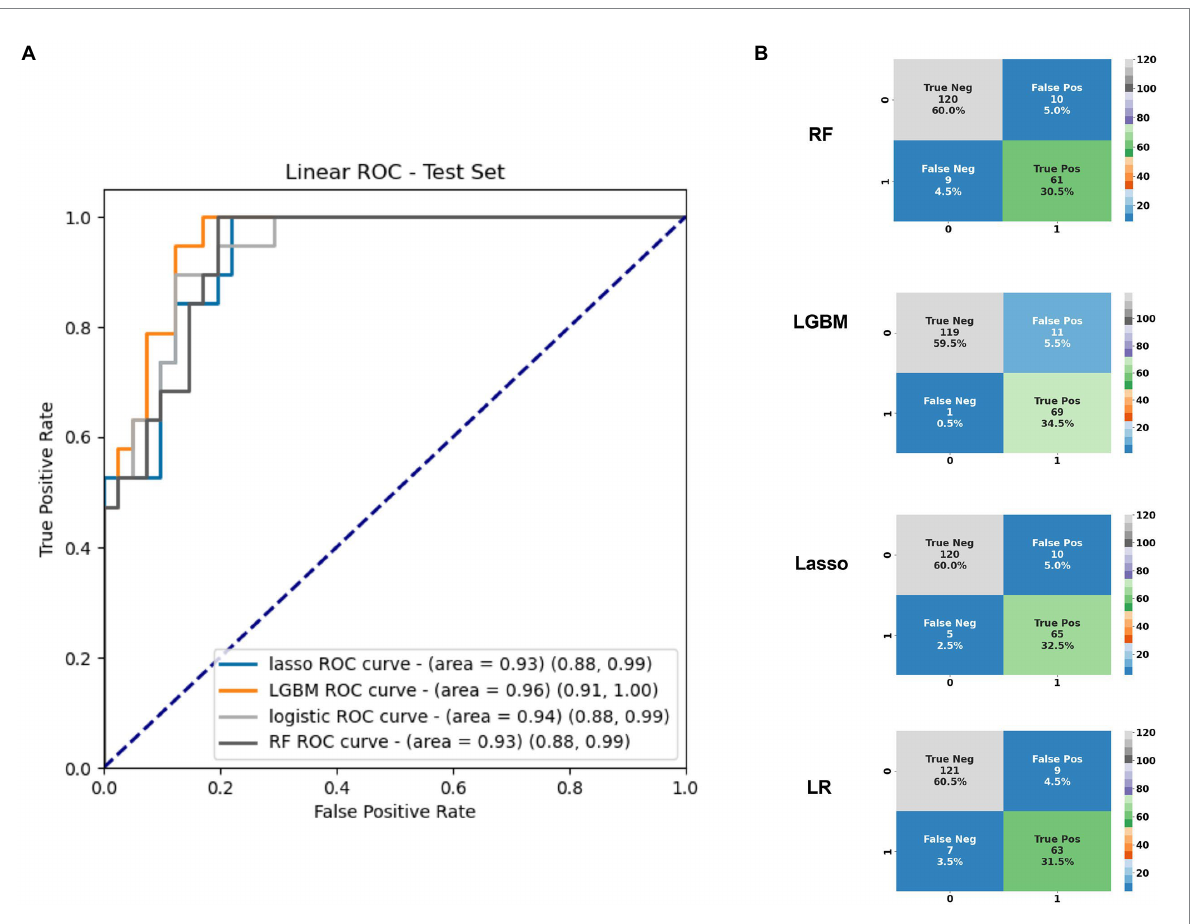
FIGURE 1 (A) Area under the receiver operating characteristic curve for the top 20 amino acids based on the test set identified in plasma differentiating infected from uninfected individuals, and (B) Confusion matrices based on the full cross-validation for each of the four models used. AUC, area under the receiver operating characteristic curve; LGBM, Light Gradient Boosted Model; LR, logistic regression; Ped, pediatric; RF, random forests; and ROC, receiver operating characteristic